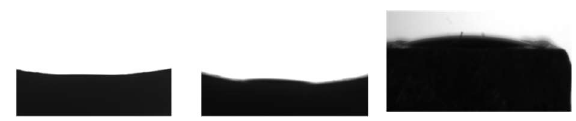
Figure 4. Contact angle of Luliang crude oil on the surface of three materials From left to right, flexible composite pipe, plastic alloy pipe and 20# steel plate.